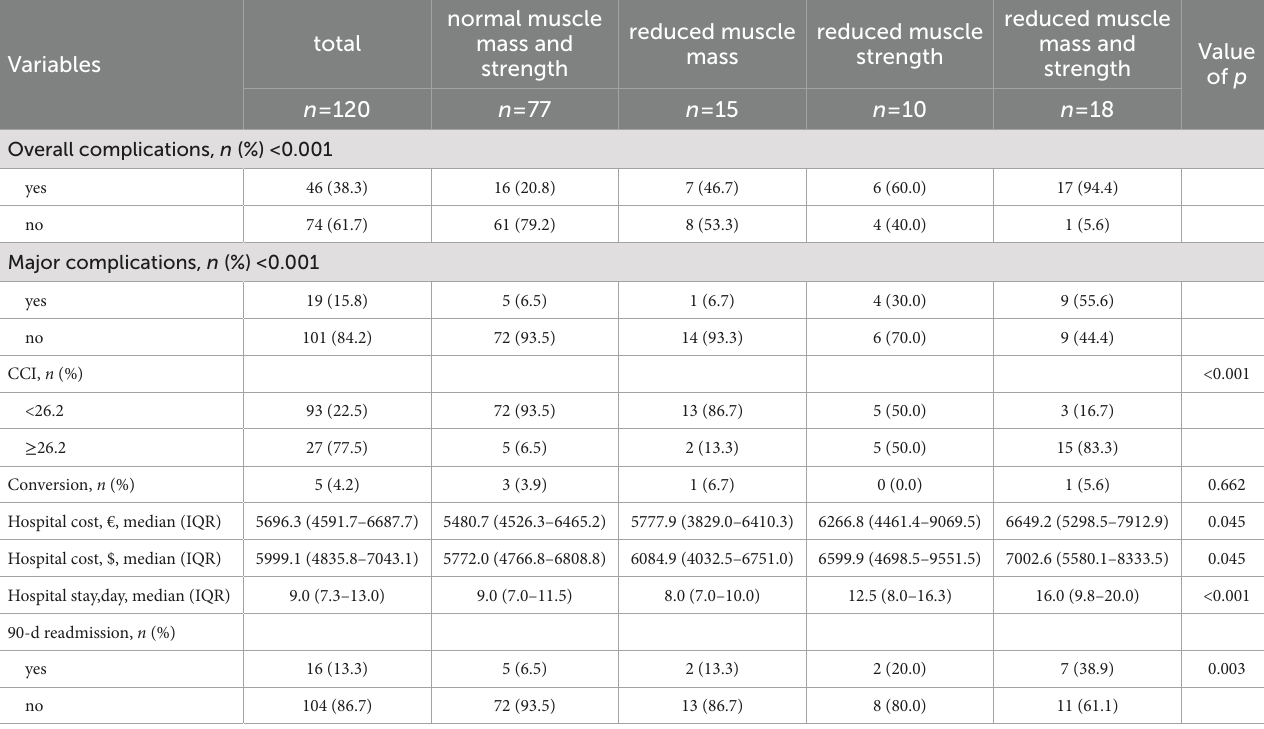
normal muscle reduced muscle reduced muscle reduced muscle total mass and mass and Value mass strength strength strength of p n = 120 n = 77 n = 15 n = 10 n = 18